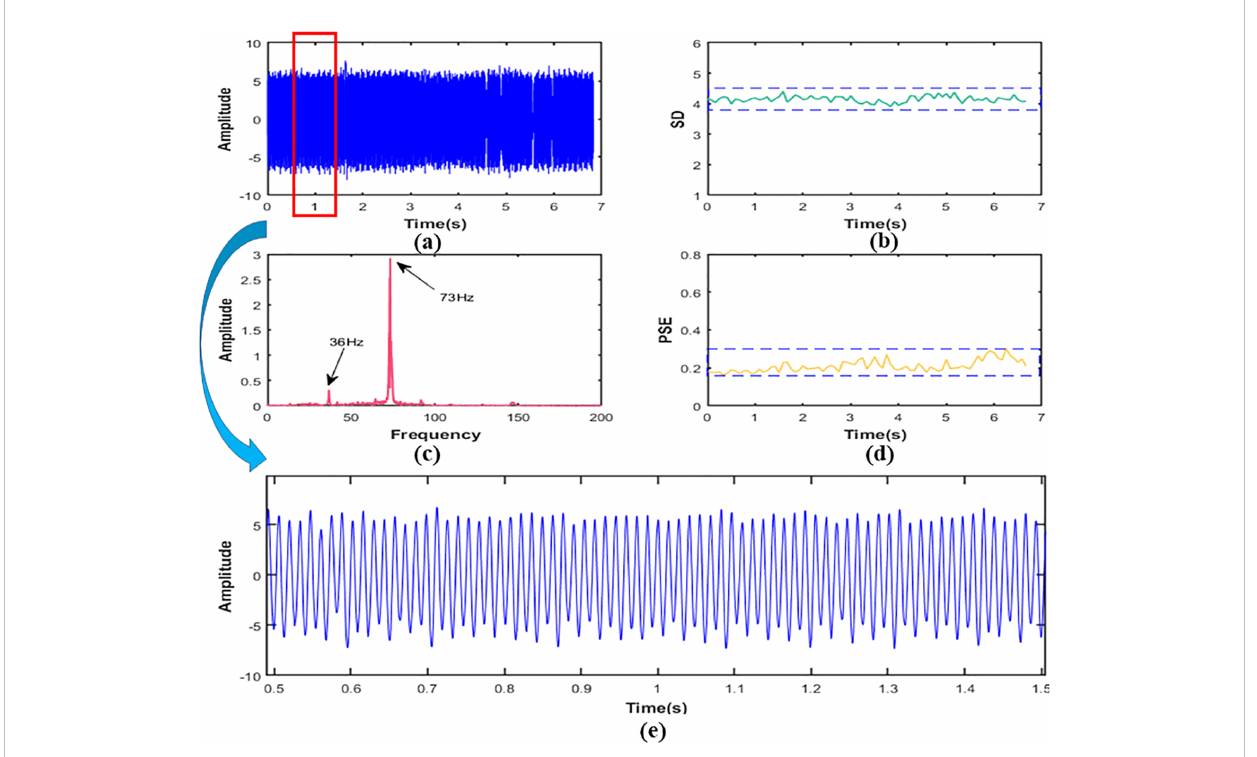
FIGURE 10 In working condition S3, signal (A) time domain fi gure, (B) the SD, (C) the PSE, (D) the FFT, (E) local ampli fi cation fi